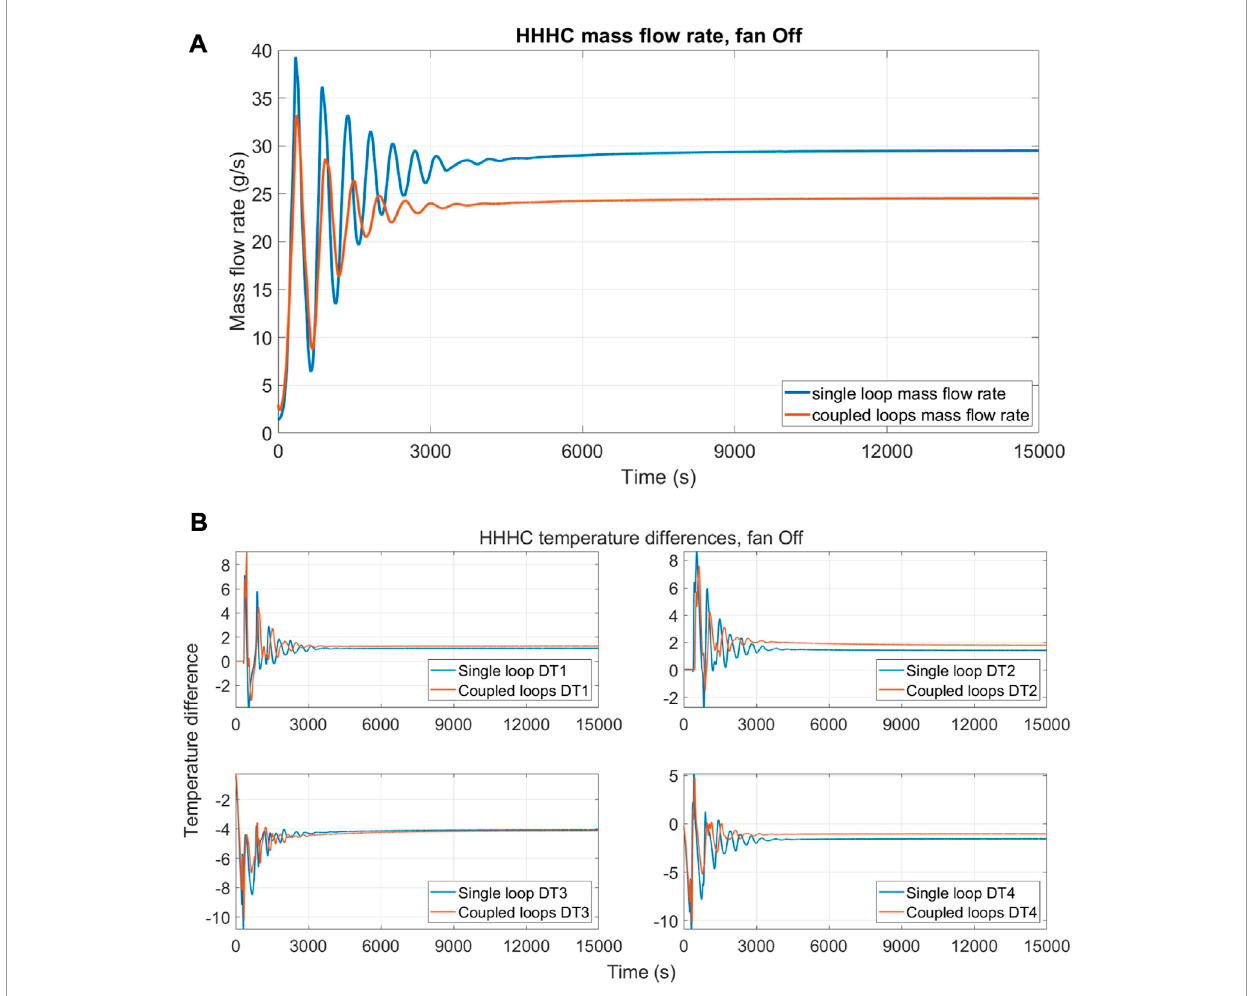
FIGURE 10 Comparison between single DYNASTY and coupled loop simulations with 0% fan speed for HHHC configuration; (A) mass flow rate evolution and (B) temperature difference